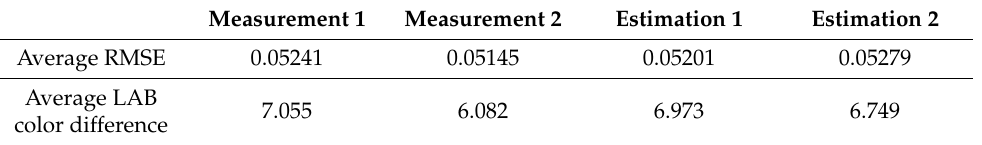
Table 4. Performance values in the four cases. For measurements 1 and 2, respectively, the directly measured spectral sensitivities by a monochromator in Figure 2a and the directly measured spectral sensitivities by a programmable light source in Figure 2b were used. For Estimations 1 and 2, respectively, the estimated spectral sensitivities using all color sample in Figure 14 and the estimated spectral sensitivities using only ten color samples in Figure 15 were